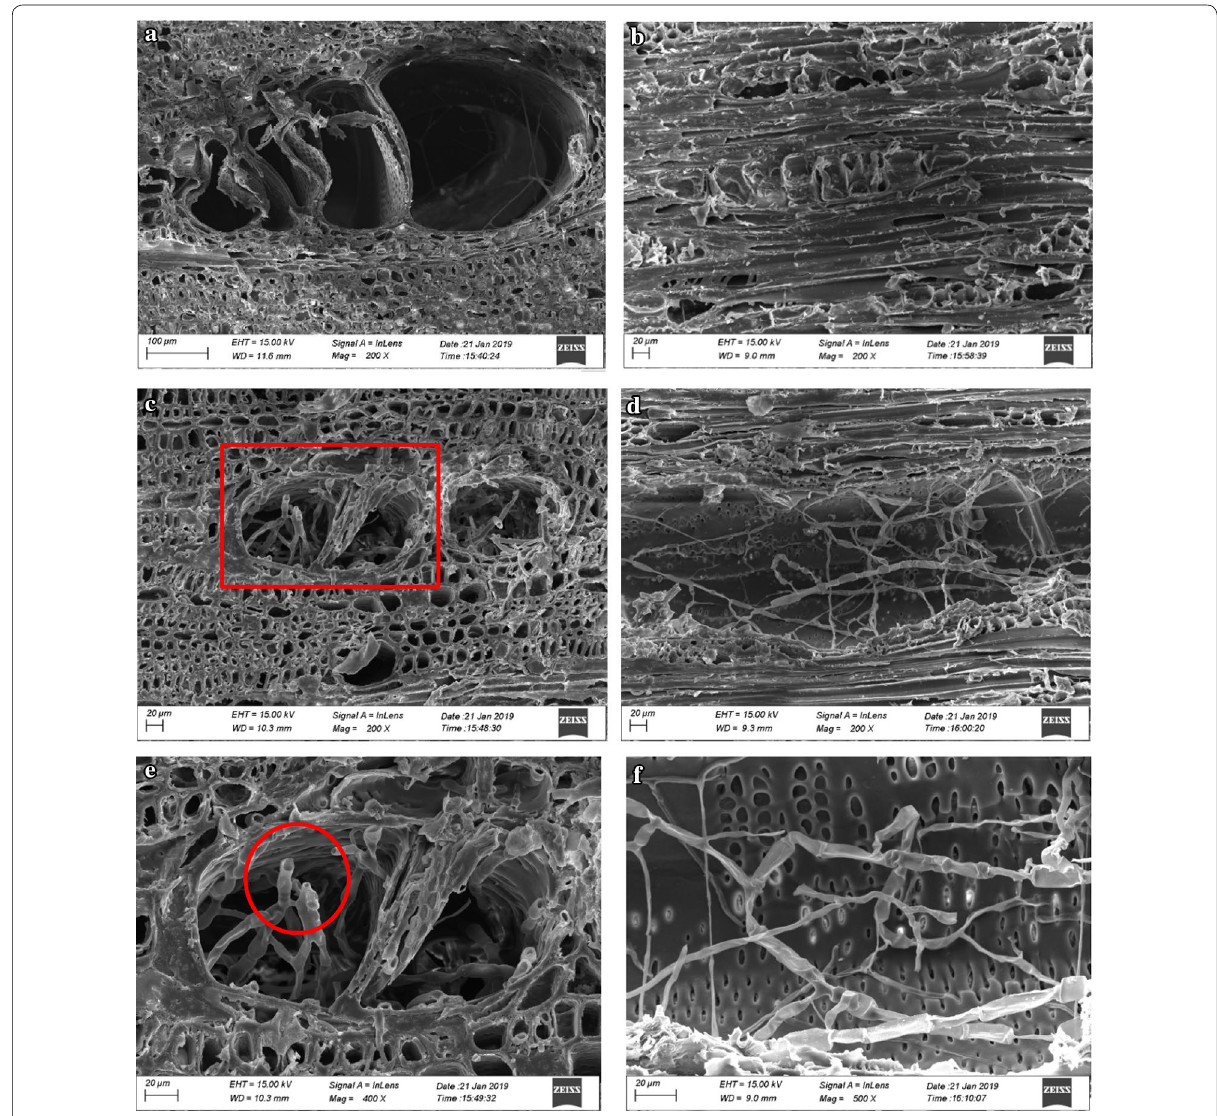
Fig. 1 SEM of vessels in undyed and dyed rubberwood. a , b SEM of undyed rubberwood on cross section and radial section; c , d SEM of rubberwood dyed with fungi on cross section and radial section at 40 days; e , f SEM of detailed chart on cross section and radial section of dyed